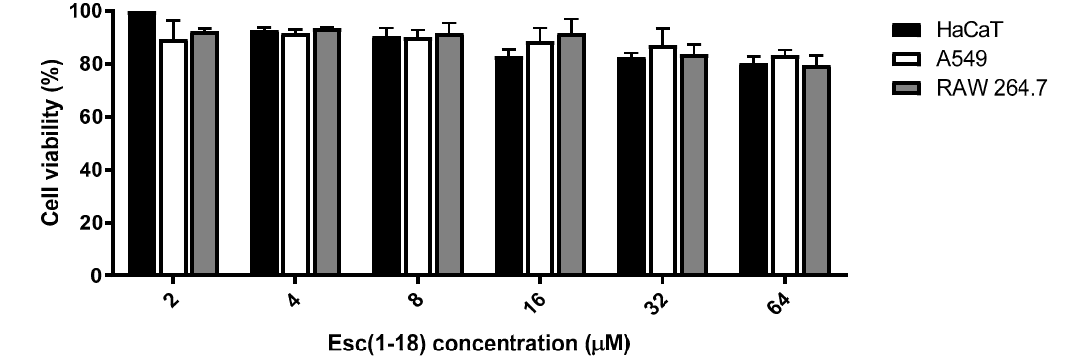
Figure 4. Dose-dependent effect of Esc(1-18) at different concentrations on the viability of HaCaT, A549, and RAW 264.7 cell lines after 24 h of treatment. The percentage of metabolically-active cells compared to untreated control samples is reported on the Y-axis. All data are the mean of three independent experiments ± SEM.